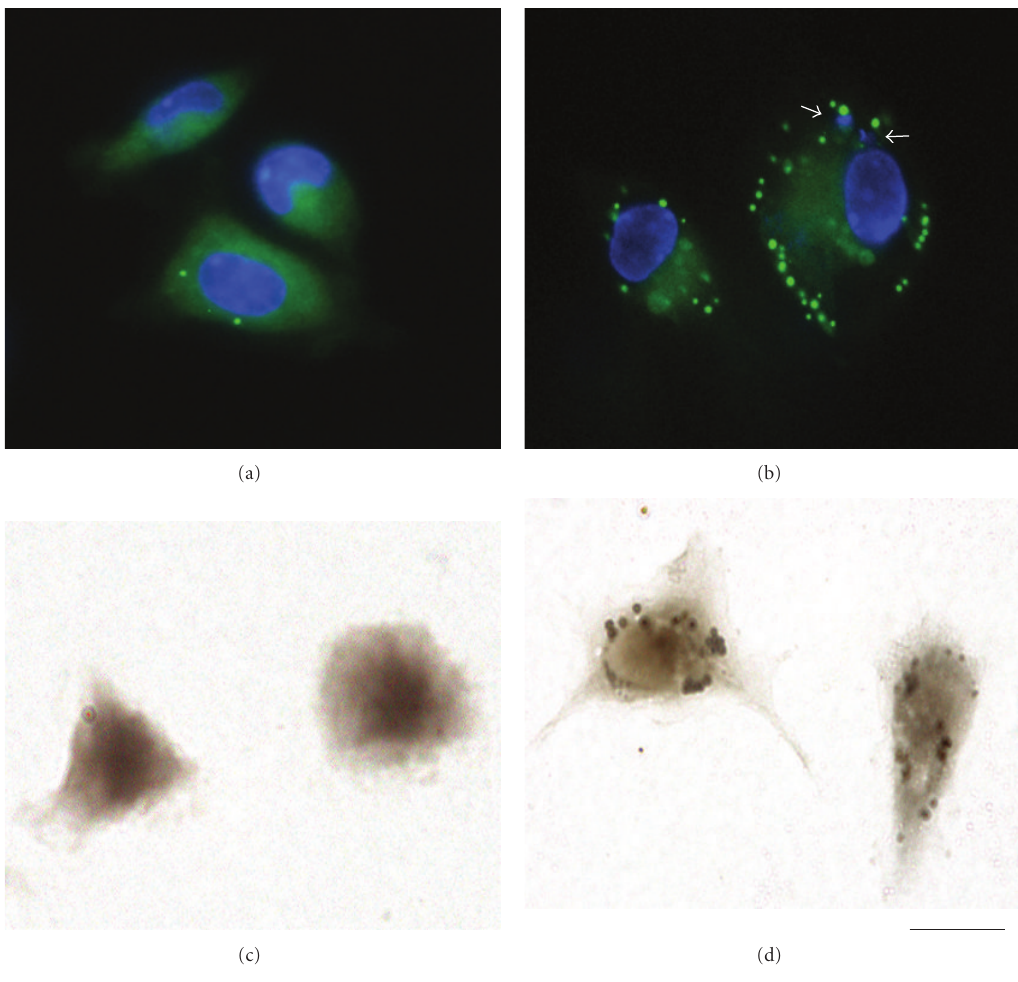
Figure 3: Trypanosoma cruzi infection induces macrophage lipid body formation. Peritoneal macrophages isolated from mice were cultured or not with T. cruzi and the formation of lipid bodies analyzed after 24 h by staining with BODIPY 493/503 (a and b), a fluorescent lipid probe for highly hydrophobic environments [35] or osmium tetroxide (c and d). While uninfected cells (a, c) have small number of lipid bodies, infected cells (b and d) show increased number of these organelles. Lipid bodies are seen as green (a and b) or brownish (c and d), round organelles. Nuclei of macrophages and internalized parasites (arrows) were stained with DAPI (4 (cid:3) ,6-diamidino-2-phenylindole; blue). Scale bar, 10 μ